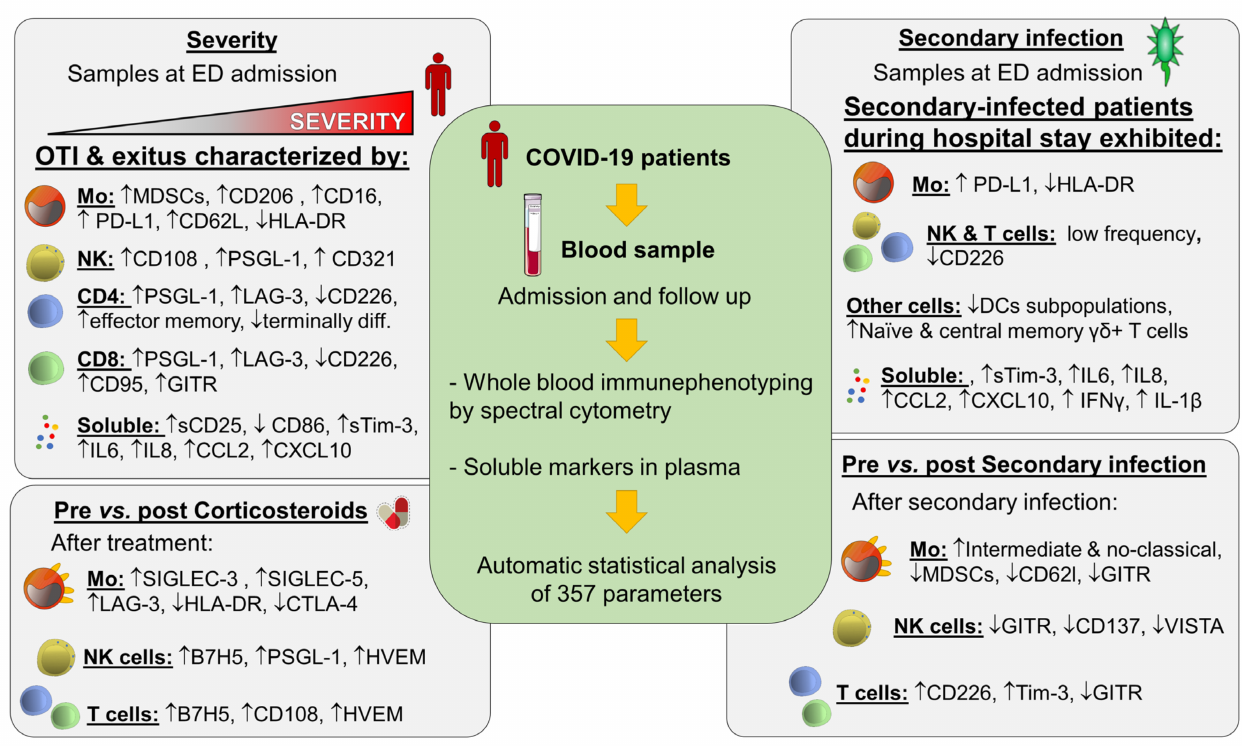
Figure 1. Graphical abstract: ED, Emergency Department; DCs, dendritic cells, MDSCs, myeloid- derived suppressor cells, Mo, monocyte; NK, natural killer; OTI, orotracheal-intubated patients; exitus, death